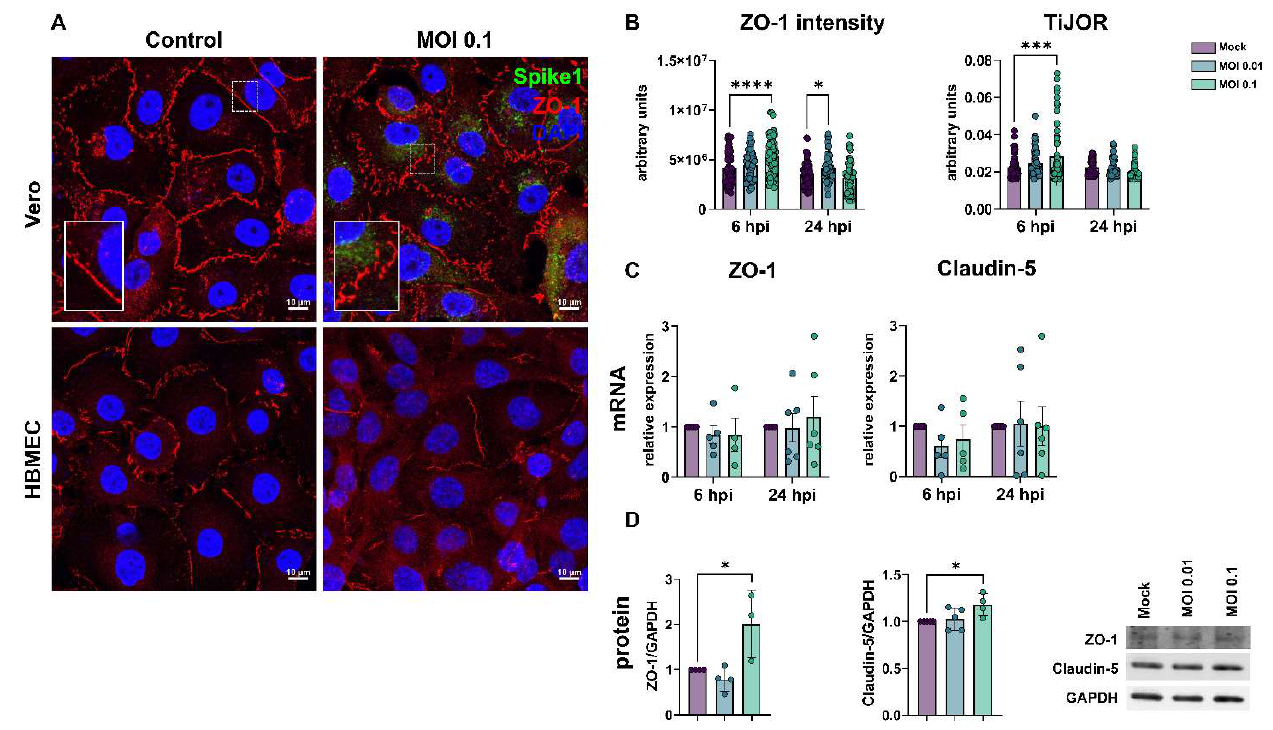
Figure 2. Effects of SARS-CoV-2 on tight junctional proteins in Vero and HBMECs. ( A ) : Cells were stained for tight junction adaptor protein ZO-1 (red) and SARS-CoV-2 Spike1 (in green). ZO-1 was affected in infected cultures at 24 hpi, as shown in higher magnification in the insets. ( B ): Morphometrical analyses of ZO-1 fluorescence intensity and TiJOR in HBMECs ( B ) showed increased ZO-1 signal and TiJOR index 6 h after exposure to the MOI 0.01. Levels of mRNA encoding for ZO-1 and claudin-5 TJ genes remained unaffected by SARS-CoV-2 challenge ( C ), but a significant increase 6 h after exposure to MOI 0.1 was observed at the protein level ( D ). *: p < 0.05 one-way ANOVA with Bonferroni post-test (in ( D )) or two-way ANOVA with Bonferroni post-test (in ( B , C )); ***: p < 0.001; ****: p < 0.0001, Two-Way ANOVA with Bonferroni post-test. Each symbol in ( C , D ) cor- responds to independent cultures, and in ( B ) corresponds to microscopic field from four independent cultures. Representative blots in ( D ) from 3–4 independent